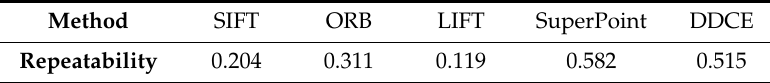
Table 6. Comparison of feature detection.